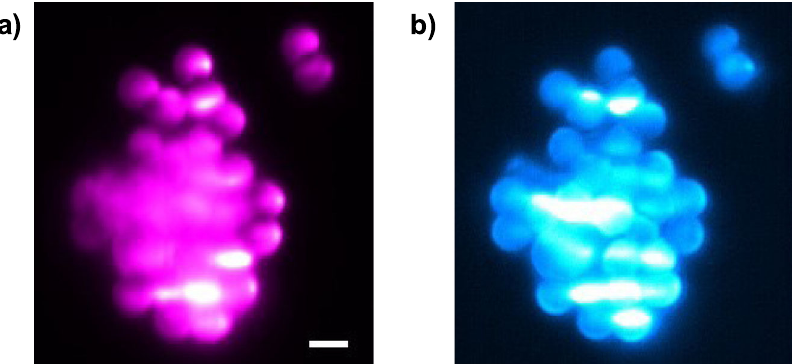
Fig. 4 Comparison of different c-TIRF imaging setups using 2 µ m diameter fl uorescent beads. A cluster of beads was imaged using a 60× 1.2 NA water objective lens on a transparent waveguide on a the upright con fi guration and b the inverted con fi guration. The c-TIRF image with the inverted con fi guration in ( b ) shows a clearer separation between beads than compared to the upright con fi guration in ( a ), especially in the more dense regions of the